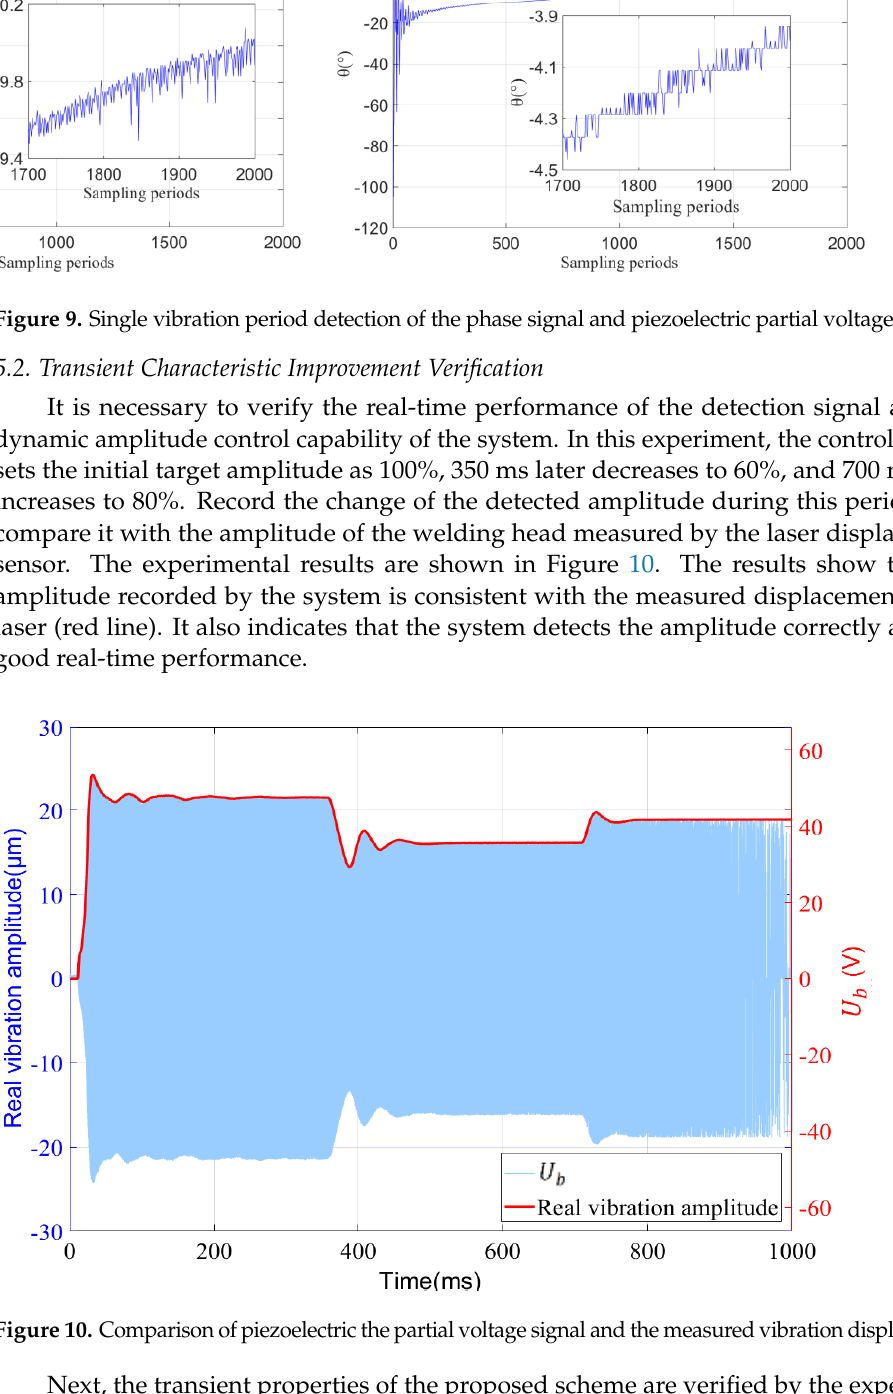
( c ) Figure 8. Experimental setup. ( a ) System frame diagram. ( b ) Controller. ( c ) Experiment frame. 5.1. Signal Transient Reliability Verification Before the experiment, first set a constant driving signal with a duty cycle of 9.09%